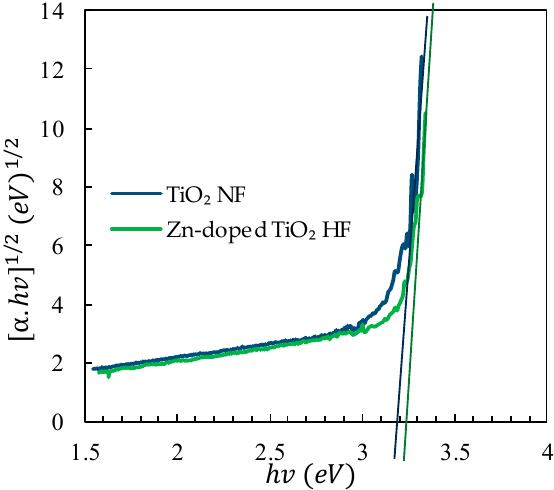
Figure 3. ( α∙ hv) 2 vs. hv curve for TiO 2 NP and Zn-doped TiO 2 HF.